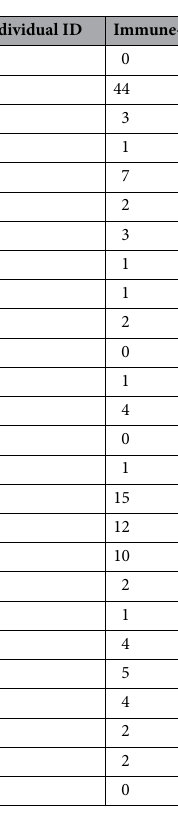
Table 3. The proportions of immune-related MMc cells (clusters 4, 6, 8, 10) and the other cell types in individual embryos. The proportions of immune-related MMc cells were significantly different among the embryos (p-value = 4.946 × 10 −6 , Fisher’s test,